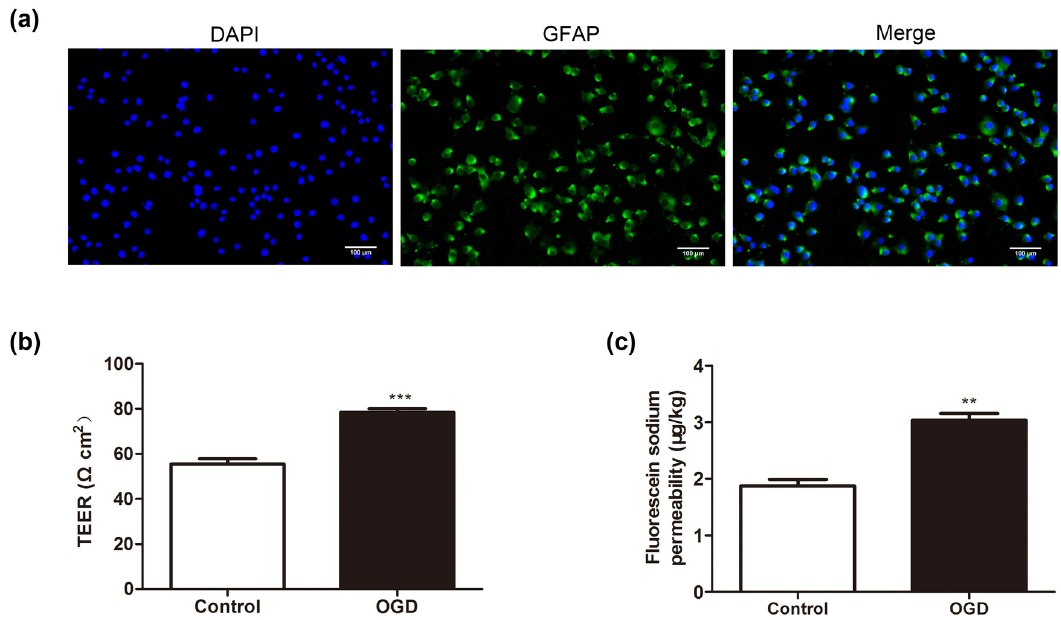
Figure 1: In fl uence of the OGD treatment of astrocytes on the permeability of BMECs. The primary astrocytes were isolated, and the primary astrocytes were treated with OGD for 3 h and then cocultured with primary brain microvascular epithelial cells ( BMECs ) for 24 h. ( a ) An immuno fl uorescence staining assay was performed to verify the isolated primary astrocytes ( scale bar: 100 µm ) . ( b ) The TEER value of BMECs was determined using the Millicell - ERS instrument ( Millipore, MA, USA ) . ( c ) Analysis of the penetration rate of NaF. OGD: oxygen - glucose deprivation, TEER: transepithelial electrical resistance, and NaF: sodium fl uorescein. Data are presented as an average of three independent assays. ** P < 0.01, *** P < 0.001 vs